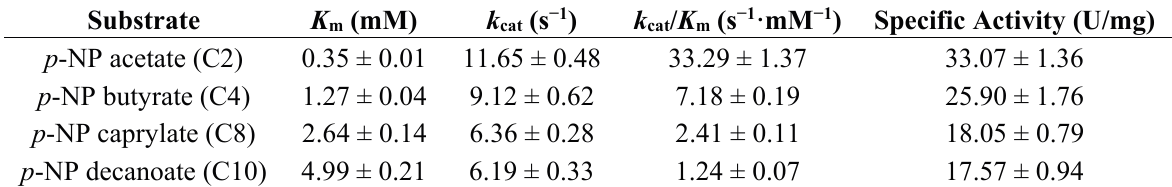
Table 2. Kinetic parameters for P186_1588 with p -NP esters.